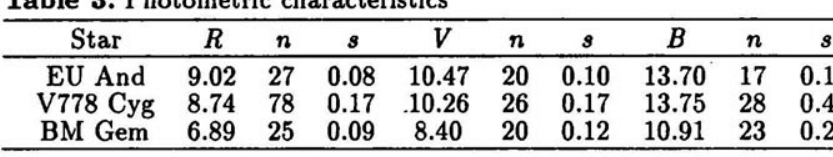
Fig. 8. Finding chart for BM Gem and comparison stars. The stars Nos. 4, 6 and 9 are out of the field. Table 3. Photometric characteristics